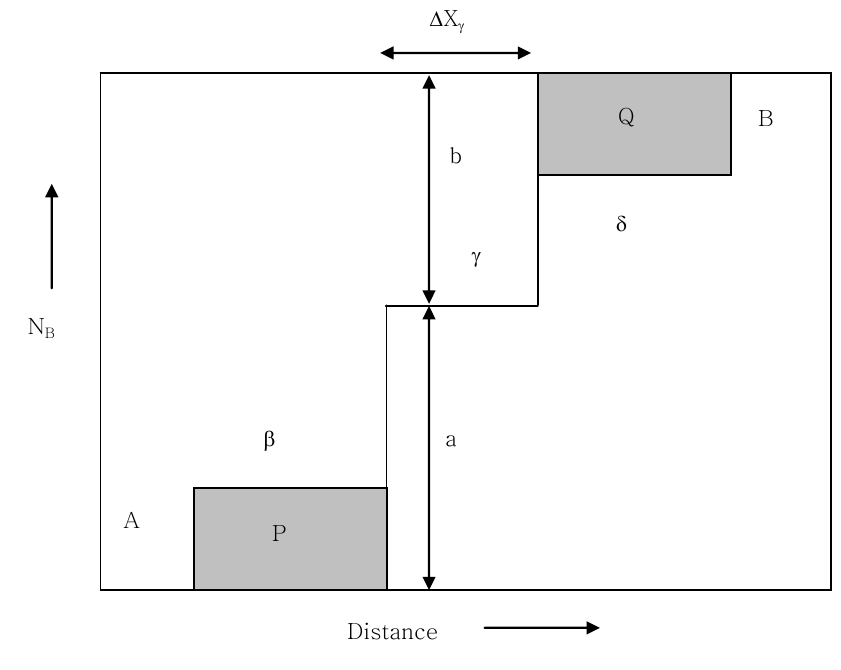
Figure 13. The schematic concentration profile of A/B diffusion couple produced β , δ and γ [7].